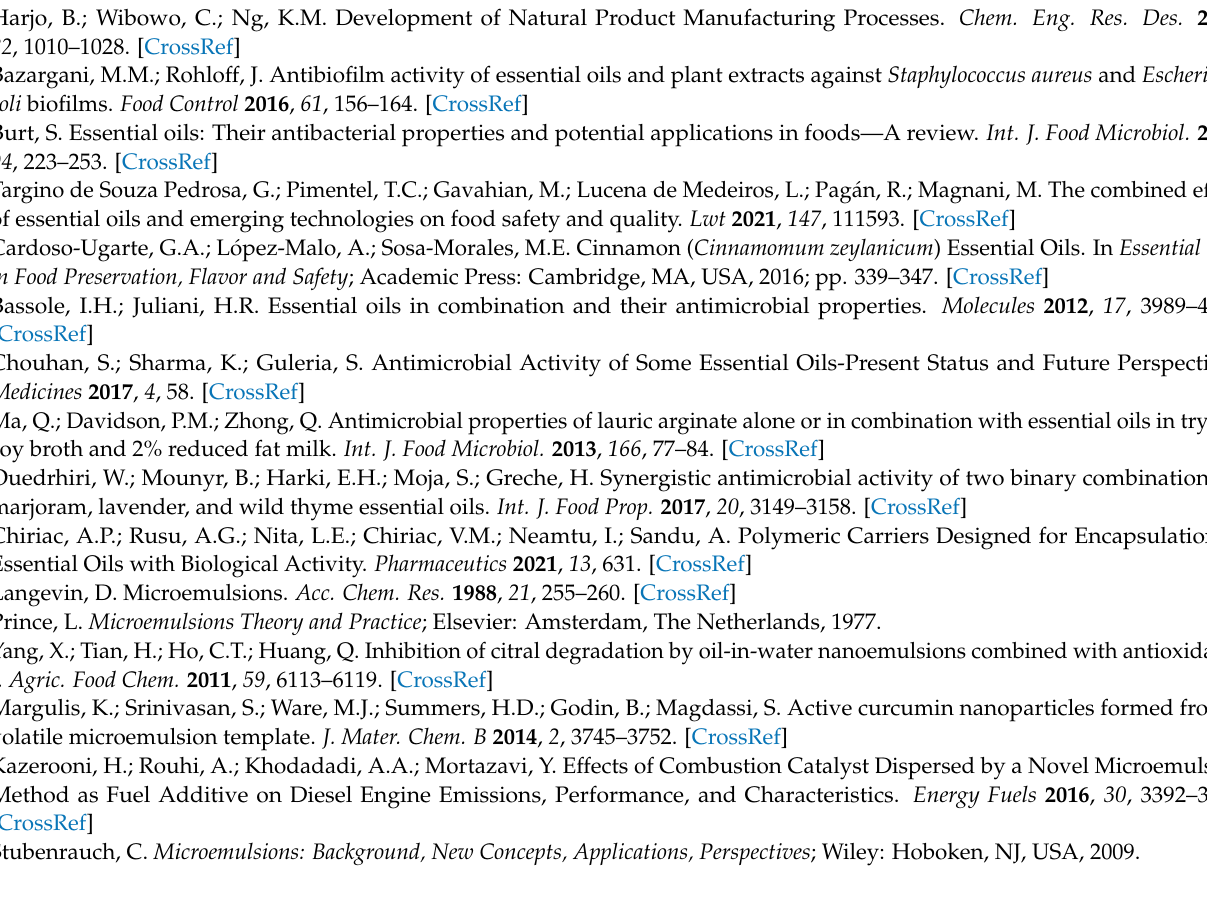
Figure S3. Diagram of the effect of different ratios of co-surfactant phase and oil phase on NMs; Table S1: The effect of different concentrations of TP on the antibacterial effect of NMs (the highest content of CEO); Table S2: The effect of different concentrations of TP on the antibacterial effect of NMs (the content of CEO is 1.5%); Table S3: Influence of the ratio of CEO to glycerin phase on the antibacterial effect of NMs (the highest content of